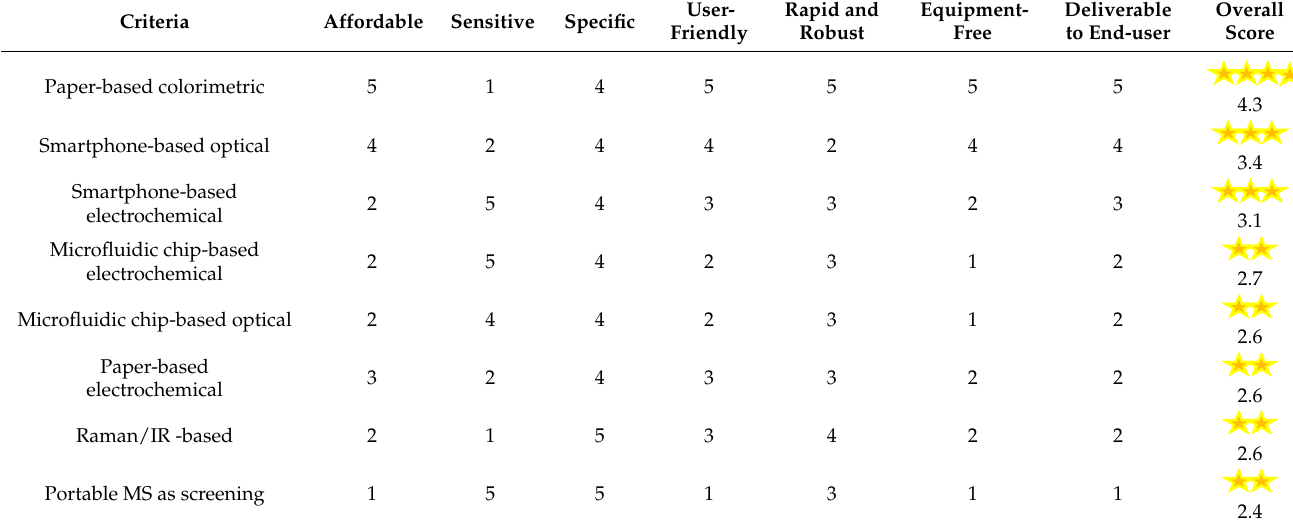
Table 1. The Affordable, Sensitive, Specific, User-friendly, Rapid and Robust, Equipment-free, and Deliverable to end-users (ASSURED) criteria grading assigned in this comparative evaluation of different types of portable food analyzers. Five stars were given to the device with the highest performance in each criterion compared with other devices. As an example, the paper-based colorimetric device is the cheapest of the portable analyzers, so it was assigned five stars in the Affordability criteria. (star